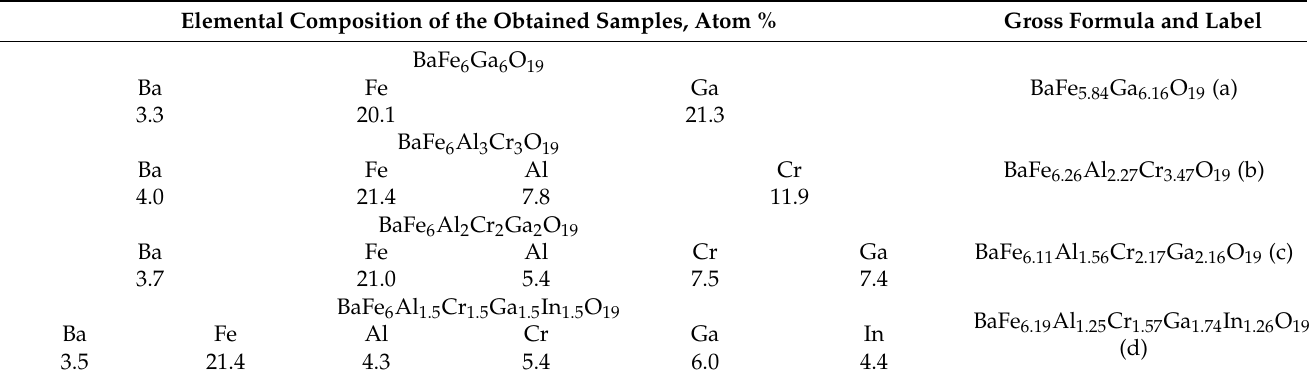
Table 3. Elemental composition of the obtained samples.